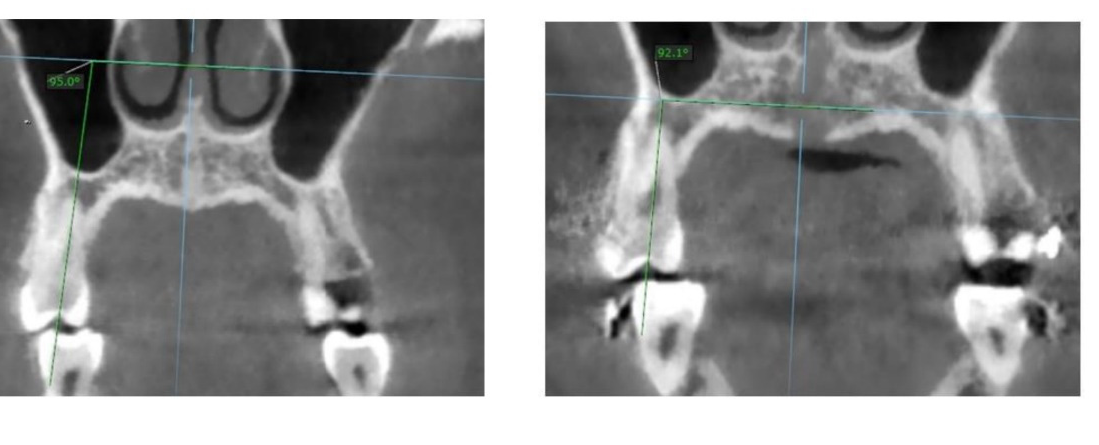
Figure 4. Illustration of measurement of tooth inclination as an angle between tooth axis and the horizontal line for: ( a ) first premolar before expansion ( left ) and after expansion ( right ); ( b ) first molar before expansion ( left ) and after expansion ( right ). Figure 5. The registration of the pre- and post-expansion CBCT by using the zygomatic and palatal bone of each side as region of interest for superimposition (the green part). After this registration, bone and tooth surfaces were constructed using the marching cubes algorithm. To visualize the direction of the tooth movement with respect to maxilla, a color contour map was generated in order to differentiate the direction of the move- ments from the surface of initial CBCT to the surface of the post-expansion (Figure 6).